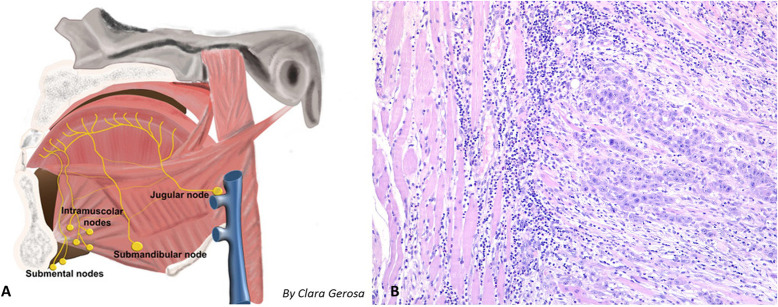
(A) Shema of the locoregional lymphatic spread of tongue malignancy, with possible intramuscular metastasis. (B) 10× Histology of an intramuscular metastasis (geniohyoid muscle) observed in a patient with pT3N2a squamous cell carcinoma of the tongue; the muscle fibers dissociated by a proliferation of epithelioid cells organized in solid nests with infiltrative growth pattern. The epitelioid cells showed polimorphic and polidimensional nuclei with prominent nucleoli, atypical mitosis and wide eosinophilic cytoplasms. In the background around and inside the tumor there is an inflammatory response composed by lymphocytes and monocytes.